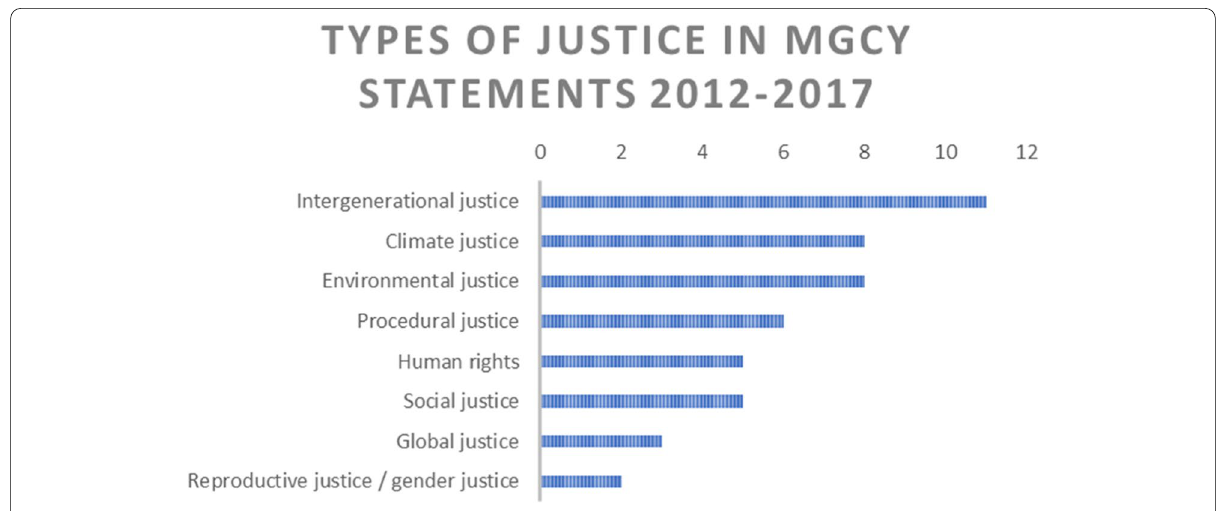
Fig. 1 Types of justice in MGCY statements